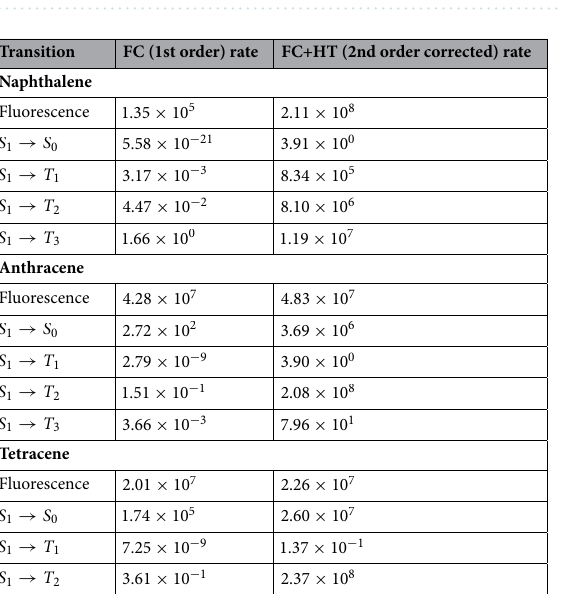
Figure 3. Calculated emission spectra of ( A ) naphthalene, ( B ) anthracene, and ( C ) tetracene. Solvation in cyclohexane was simulated via a PCM at both the Franck–Condon (Red) and Herzberg–Teller (Blue) levels. Spectra are normalised by intensity, and as such are not to scale. ( B , C ) were taken from Ref. 10 with permissions.